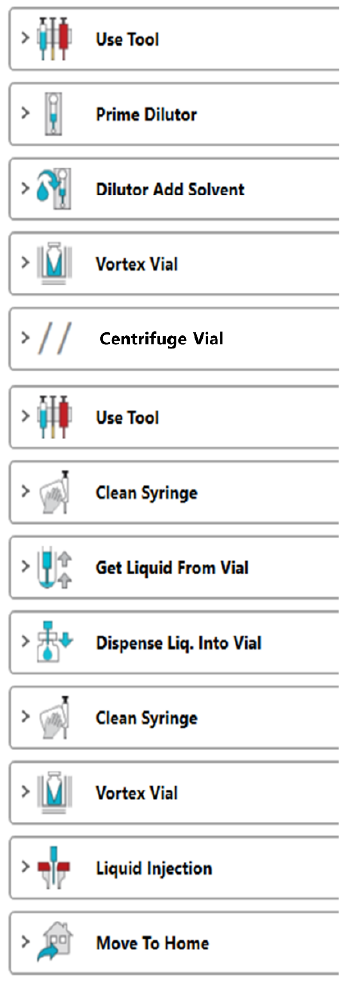
Figure 2. Scheme of the basic steps for the liquid-liquid extraction experiment represented in the PAL Method Composer software style. Each menu item consists of a set of parameters which have to be adjusted and optimized.